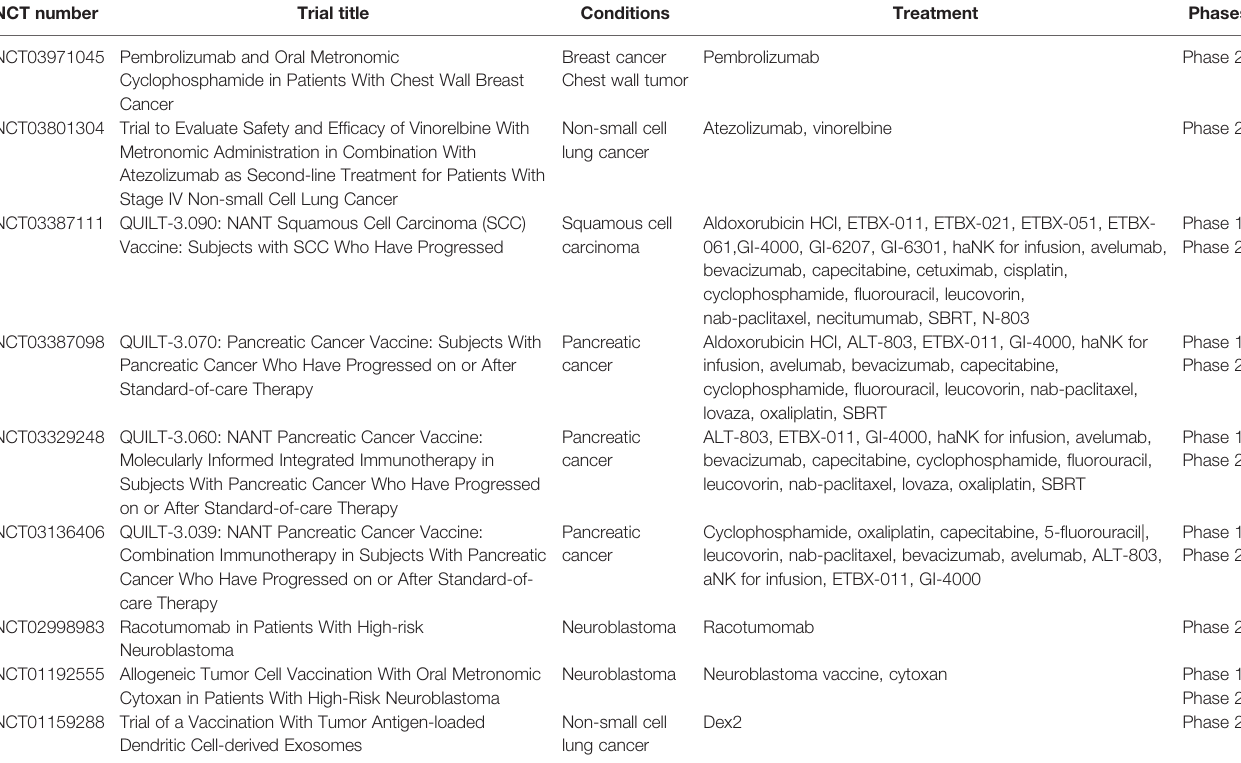
TABLE 2 | Clinical trials combining metronomic chemotherapy with immuno-oncology